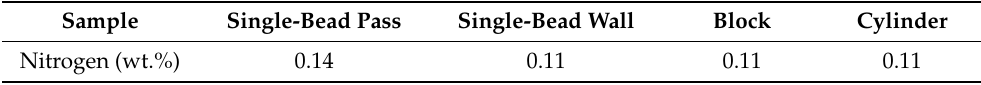
Table 4. Nitrogen measurement of as-deposited LMDw samples by combustion analysis.